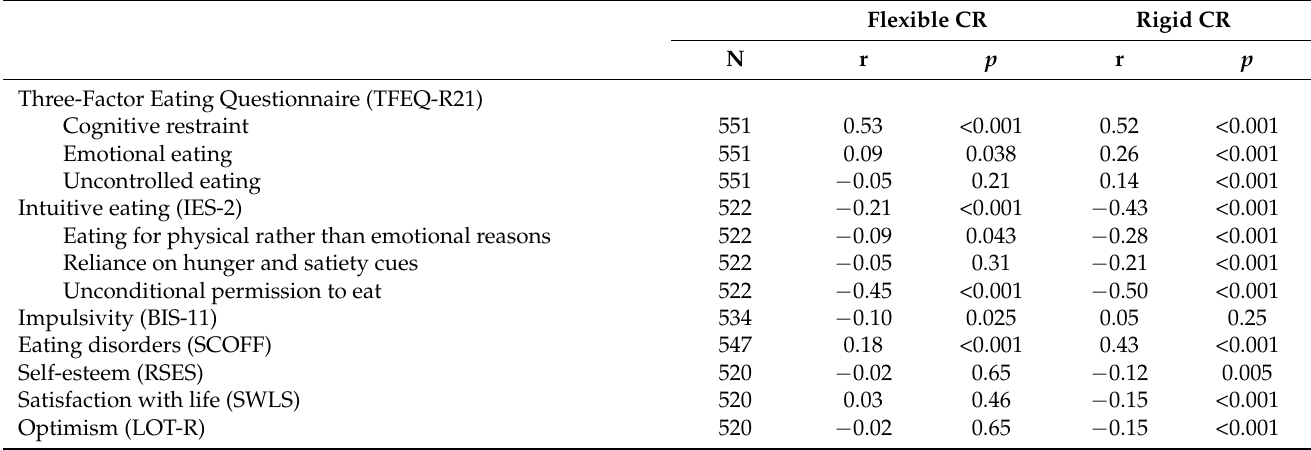
Table 4. Pearson’s correlation coefficients between the flexible and rigid cognitive restraint (CR) scales and different eating behaviors and psychological well-being characteristics, such as cognitive restraint, uncontrolled eating, emotional eating, intuitive eating, eating disorders, self-esteem, impulsivity, satisfaction with life and optimism, in the NutriNet-Sant é study